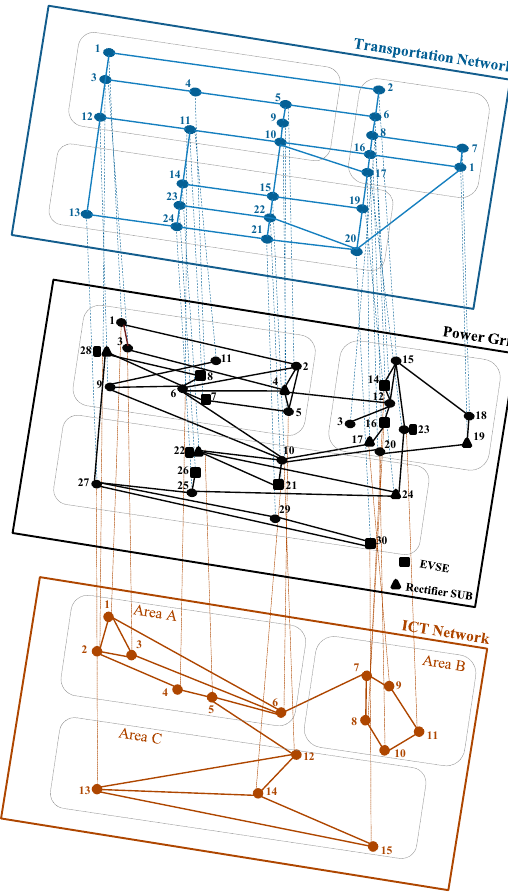
Figure 1. The integrated structural interdependency graph 𝓖 (cid:3020) = (𝕍 (cid:3020) , 𝔼 (cid:3020) ) .